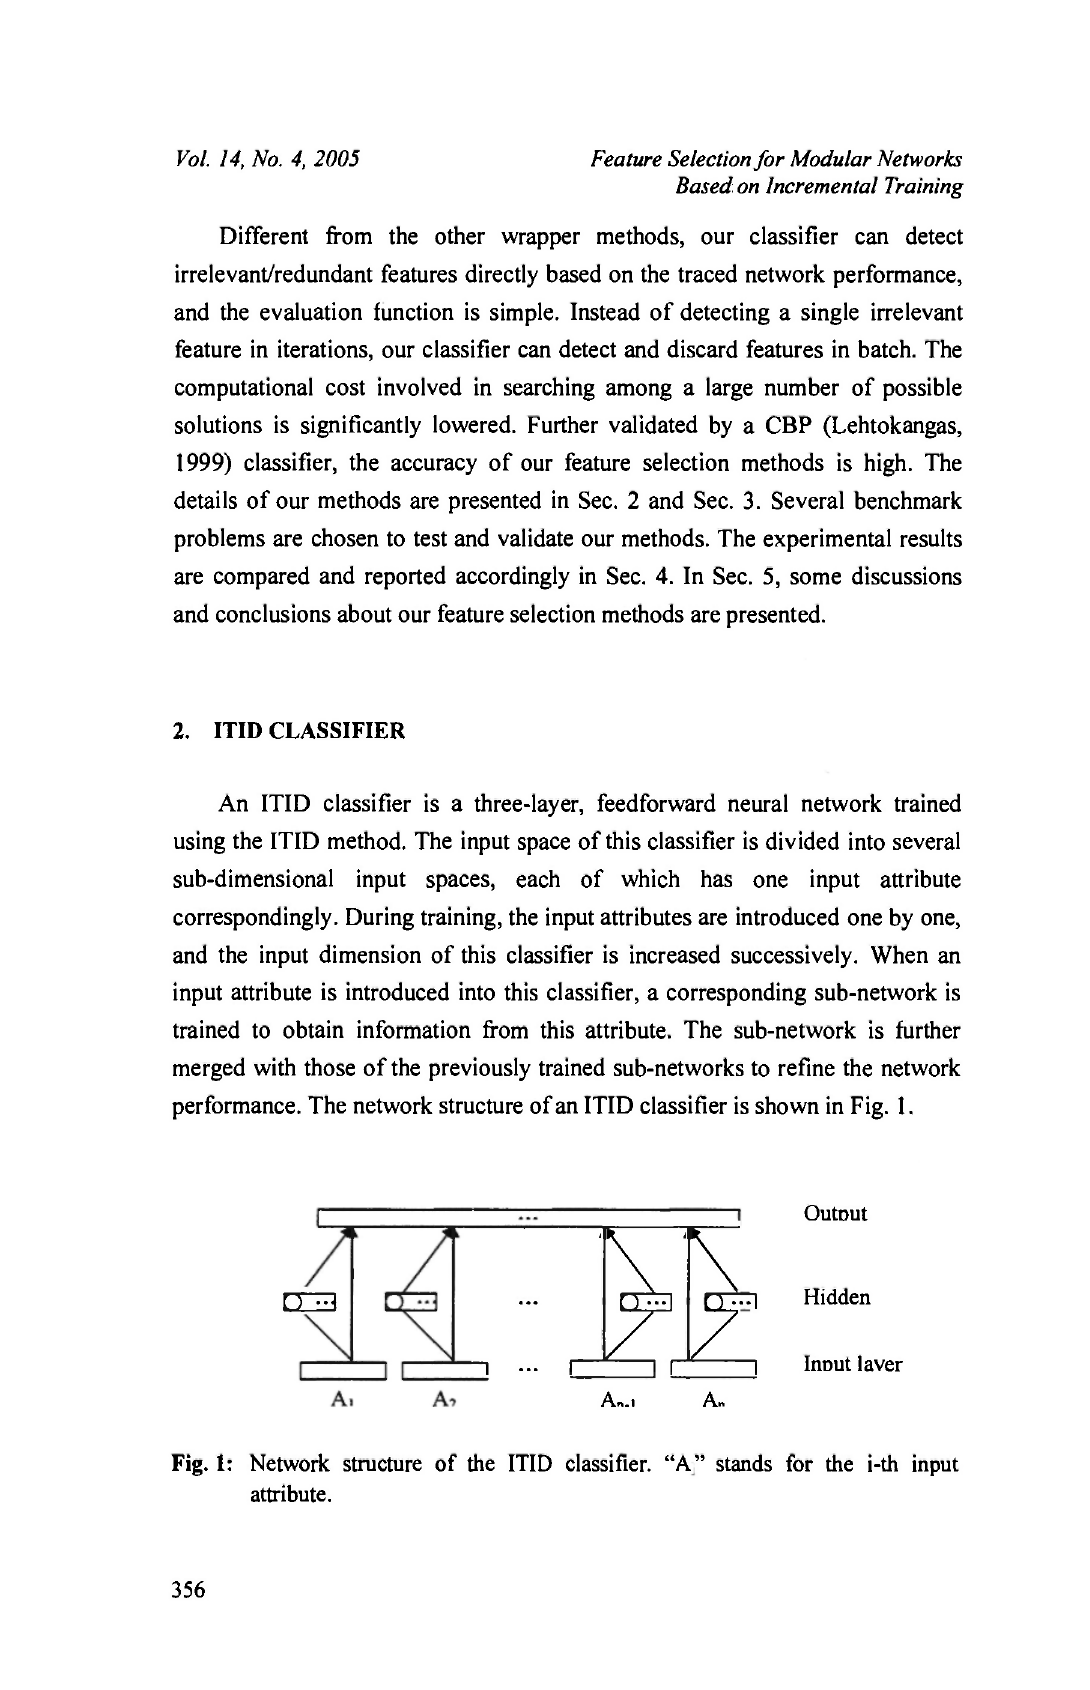
Fig. 1: Network structure of the ITID classifier. "A" stands for the i-th input